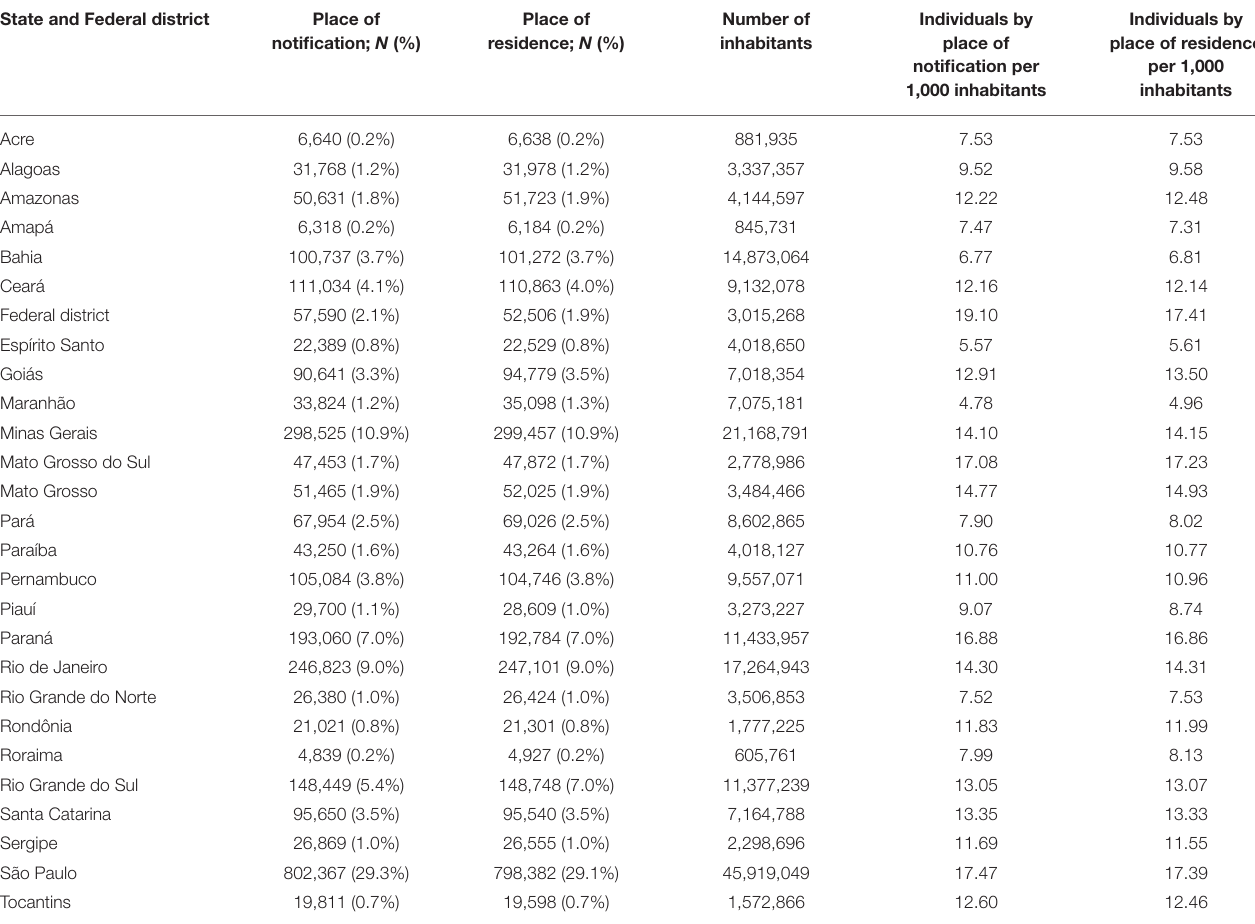
TABLE 1 | Distribution of the hospitalized patients due to severe acute respiratory infection (SARI) in Brazil during the Coronavirus Disease (COVID)-19 pandemic according to the patients’ place of notification and residence. State and Federal district Place of Place of notification; N (%) residence; N